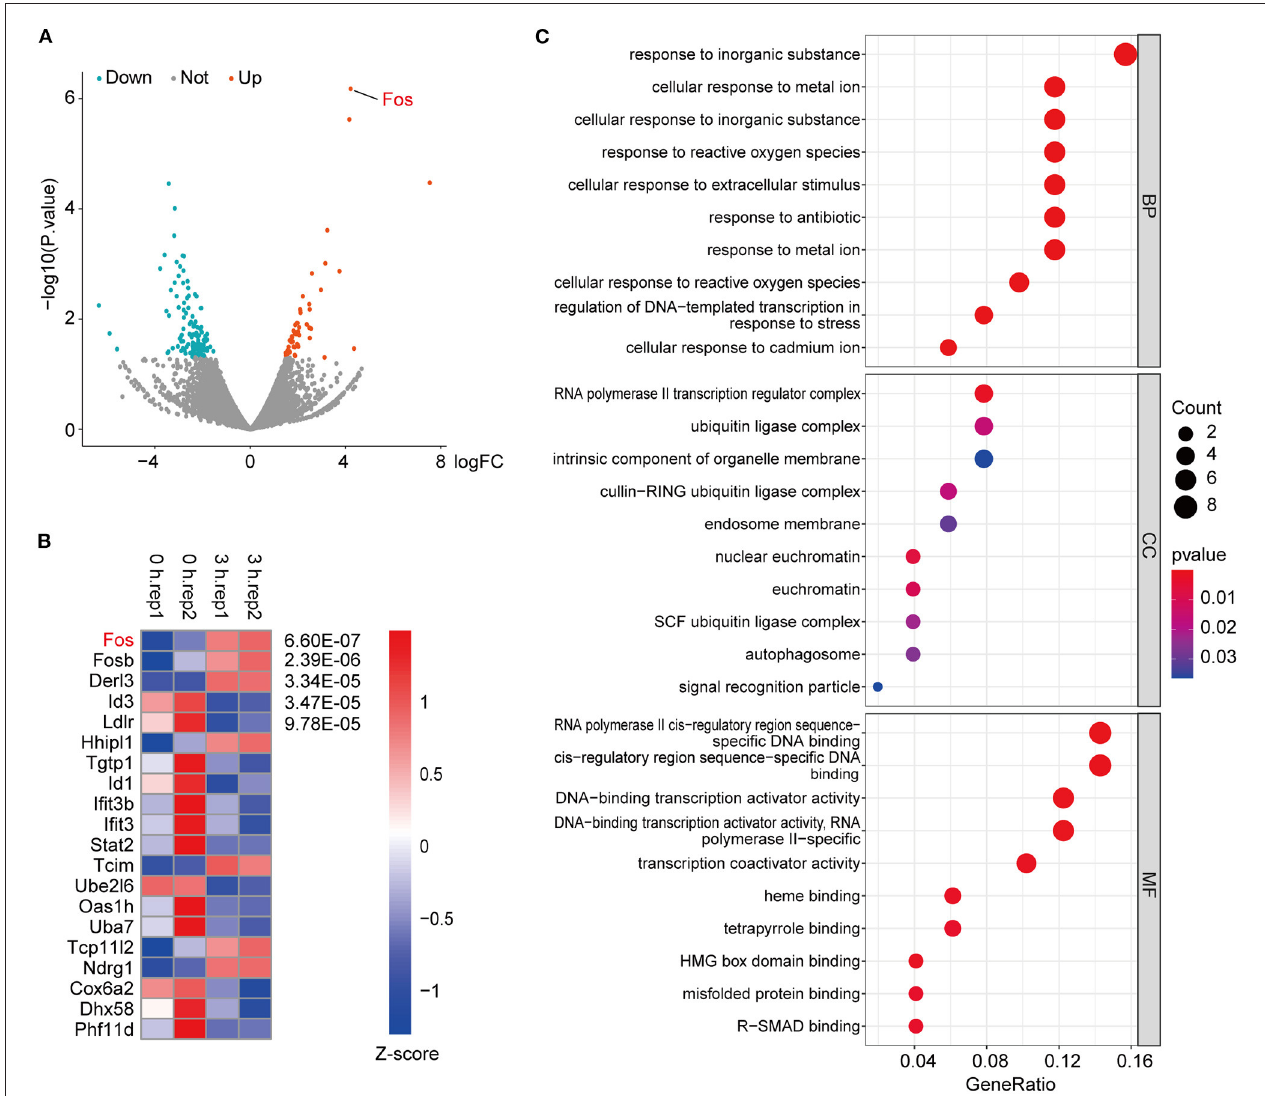
FIGURE 3 | RNA-sequencing of oxygen–glucose deprivation (OGD)-treated HT22 cells. (A) These criteria identified 51 upregulated and 119 downregulated genes in 3 vs. 0h, as shown in the volcano plot, in which the red and green spots represent upregulated and downregulated differentially expressed genes (DEGs), respectively. (B) The top 20 genes with the smallest p -value among the DEGs were extracted, through normalizing the log2-based TPM + 1 value and the expression matrix by Z -score and using the R package pheatmap to make a map. (C) Gene ontology (GO) enrichment analysis of the upregulated DEGs in RNA-seq data. Gene ratio indicates the number of genes enriched in one pathway compared with the total genes changed in all pathways. Count indicates the number of genes. The colors represent p -value, and red is the highest. BP, biological process; CC, cellular component; MF, molecular function.